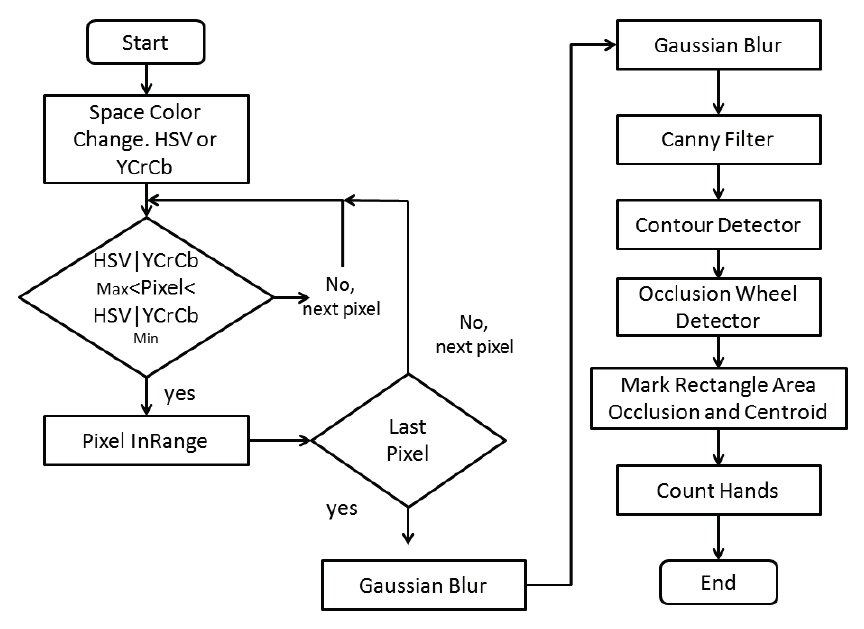
Figure 6. Skin detection